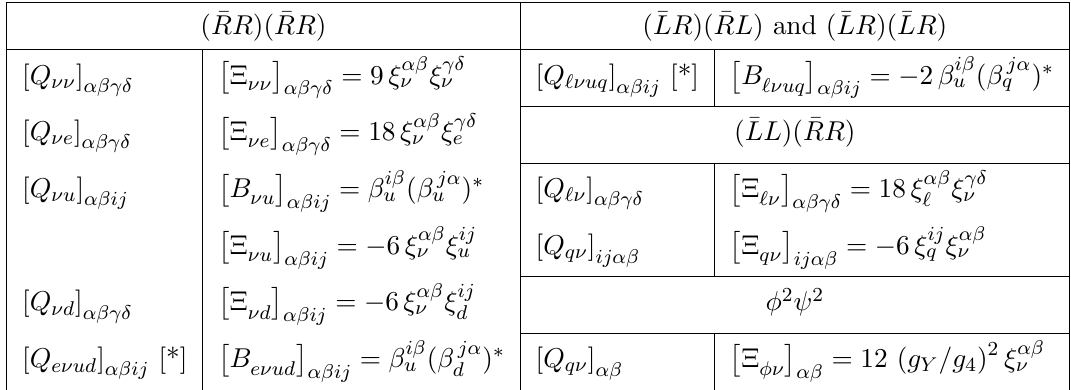
Table 5 . Wilson coe(cid:14)cients of four-fermion operators involving right-handed neutrinos. For the operators denoted with a [*], the hermitian conjugate has to be considered as well.